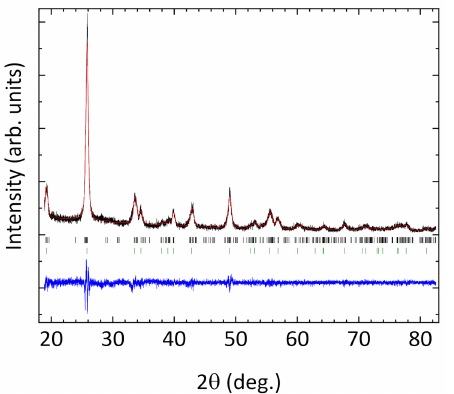
Figure 3. XRD pattern and Rietveld refinement of LiAl(IO 3 ) 4 nanopowders. Black line: experimental data; red line: Rietveld refinement; blue line: residuals; black and green ticks: Bragg reflections calculated using the monoclinic P 2 1 and the hexagonal P 6 3 space group, respectively. R-factors of the Rietveld refinement: R p = 10.41%, R wp = 14.28%, χ 2 =